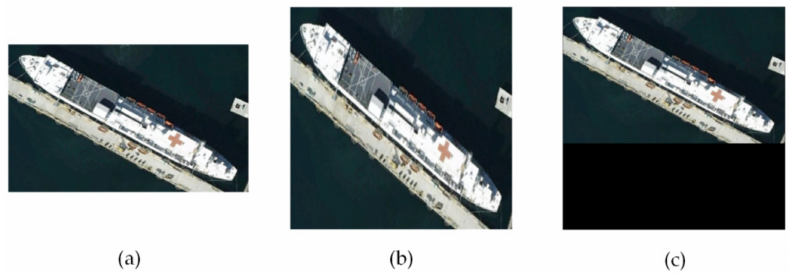
Figure 10. Different size adjustment methods. ( a ) is the original image; ( b , c ) are downsampling and zero-padding methods, respectively. The zero-padding method in ( c ) preserves more ship shape information than the method in ( b